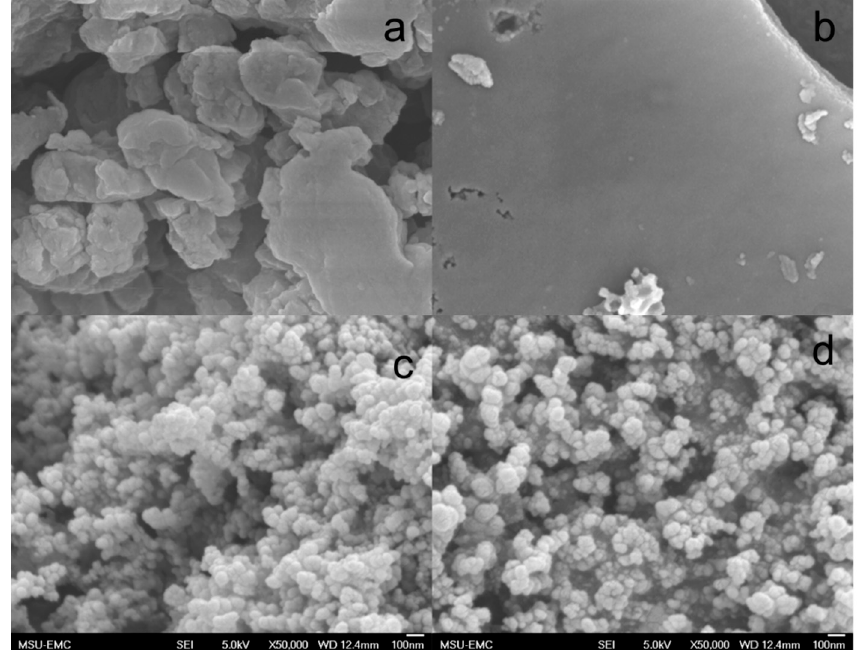
Figure 6. SEM images of raw kraft lignin ( a ) and solid products of kraft lignin thermally decomposed at 1000°C under three different atmospheres of Ar ( b ), CO 2 ( c ), and H 2 ( d ).